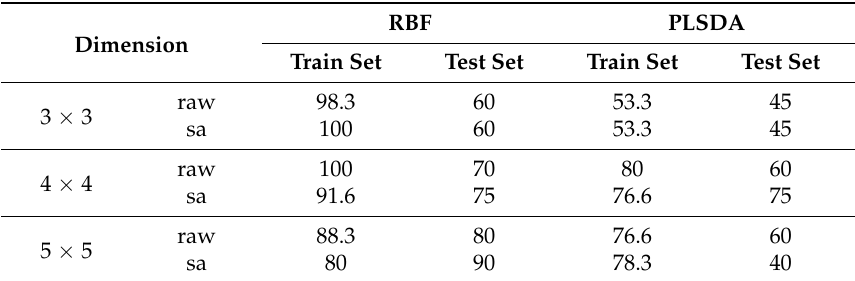
Table 6. Accuracy with partial least squares discriminant analysis (PLSDA) and RBF (%). RBF PLSDA Dimension Train Set Test Set Train Set Test Set raw 98.3 60 53.3 45 3 × 3 sa 100 60 53.3 45 raw 100 70 80 4 × 4 sa 91.6 75 76.6 75 raw 88.3 80 76.6 60 5 × 5 sa 80 90 78.3 40 Note: “sa” in Table 6 represents “spares autoencoder”.